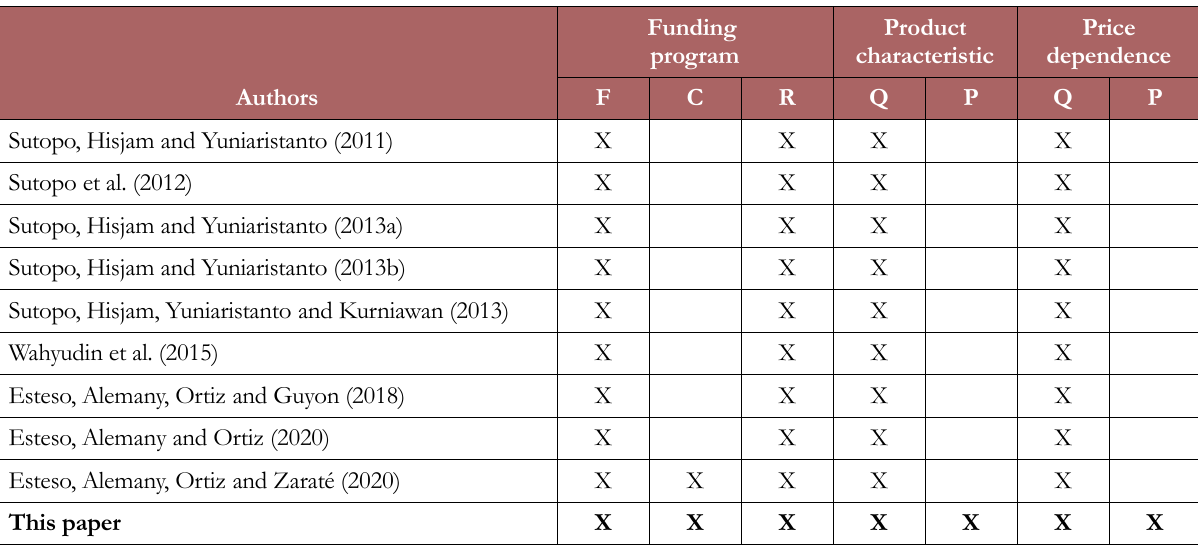
Table 1. Literature review (Part